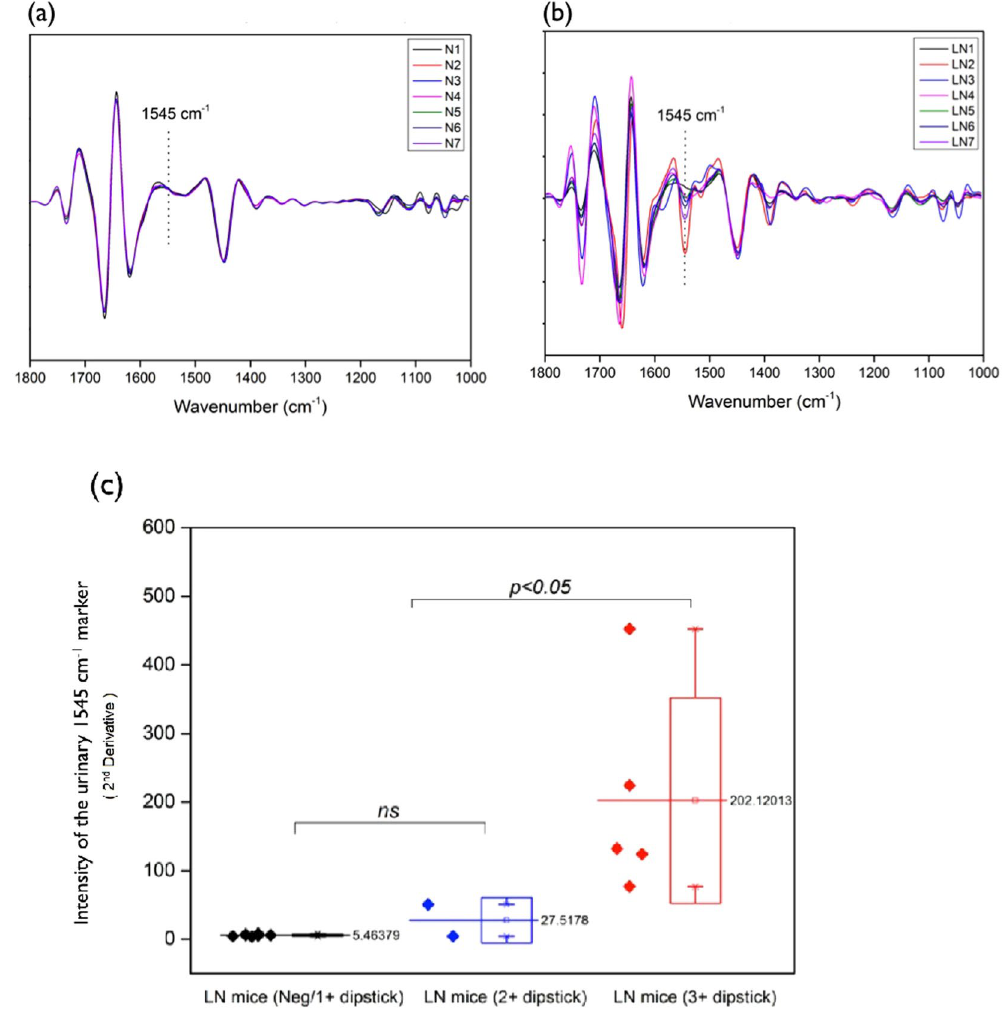
Figure 8. ( a ) Normalized 2 nd derivative IR spectra of seven (NZB x NZW) F1 mice with negative to 1 + protein by dipsticks (i.e. negative to trace protein for the samples including N1, N2, N4, N5, N6 and N7, and 1 + proteinuria for the sample N3 ( b ) Normalized 2nd derivative IR spectra of seven (NZB x NZW) F1 mice with 2 + proteinuria (the samples of LN1 and LN4) and 3 + proteinuria (the samples of LN2, LN3, LN5, LN6 and LN7). ( c ) The intensity of the urinary 1545 cm − 1 spectral marker in LN mice with negative/1 + protein (n = 7), LN mice with 2 + protein (n = 2) and LN mice with 3 + protein (n = 5). The mice with significant proteinuria (3 + positive) had the highest level of the 1545 cm − 1 peak intensity compared to the other two groups, but there was no significant difference between mice with negative and mild proteinuria ( ≤ 2 + protein). (The data are expressed as mean ± SD, analyzed by one way ANOVA with Fisher’s LSD post hoc